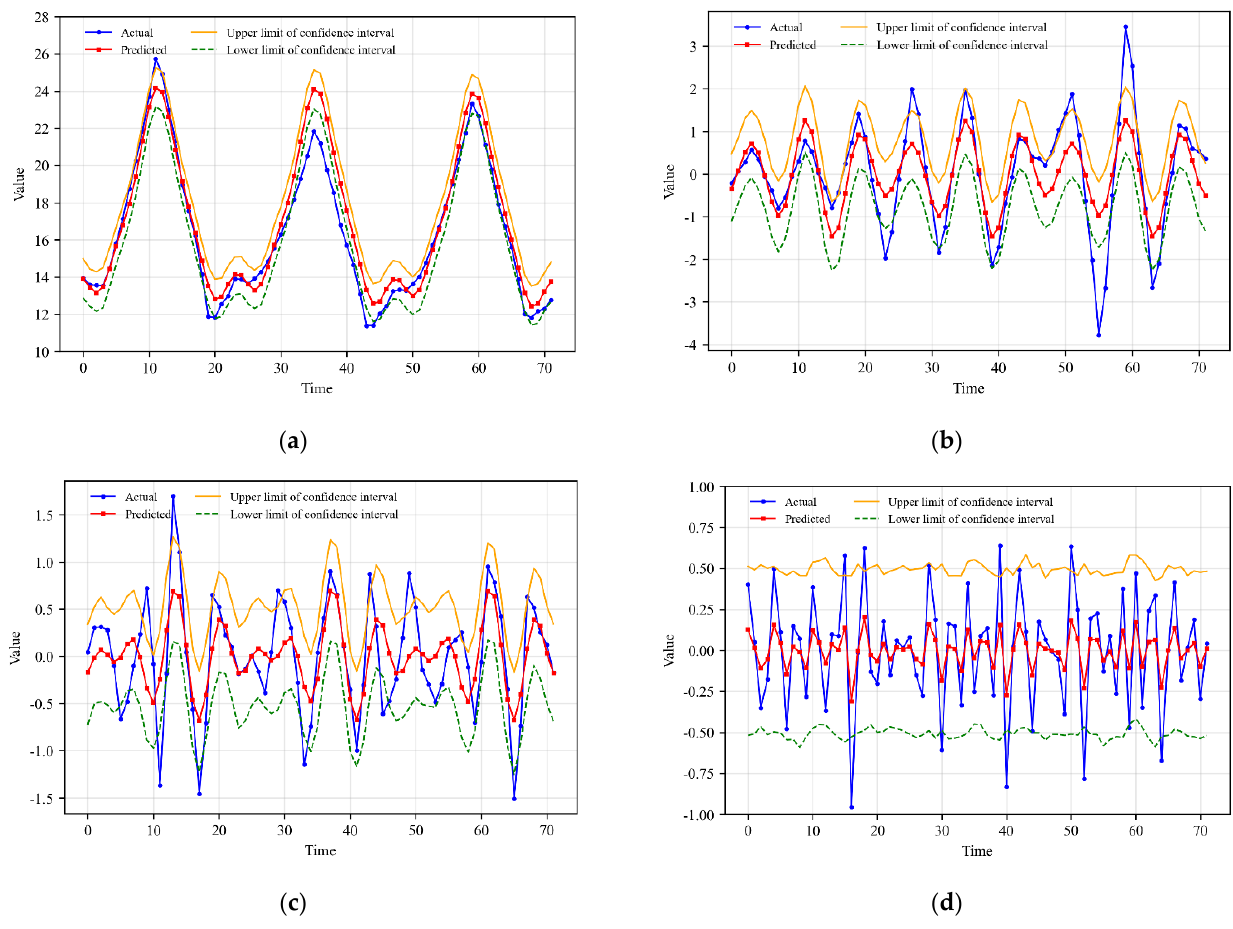
Figure 9. Comparison of the actual and predicted results of the four components of the test set: ( a ) A 3 ; ( b ) D 3 ; ( c ) D 2 ; ( d ) D 1 .